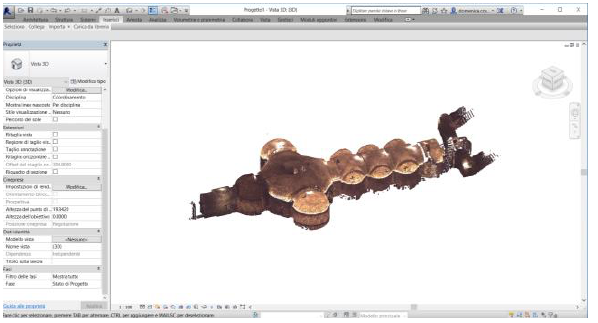
Figure 18. Crypt cloud point represented in Revit environment The cloud points total was subsequently used as a guideline in order to draw the main structural components (walls, floors, vault, steps, etc.), as shown in figure 19.